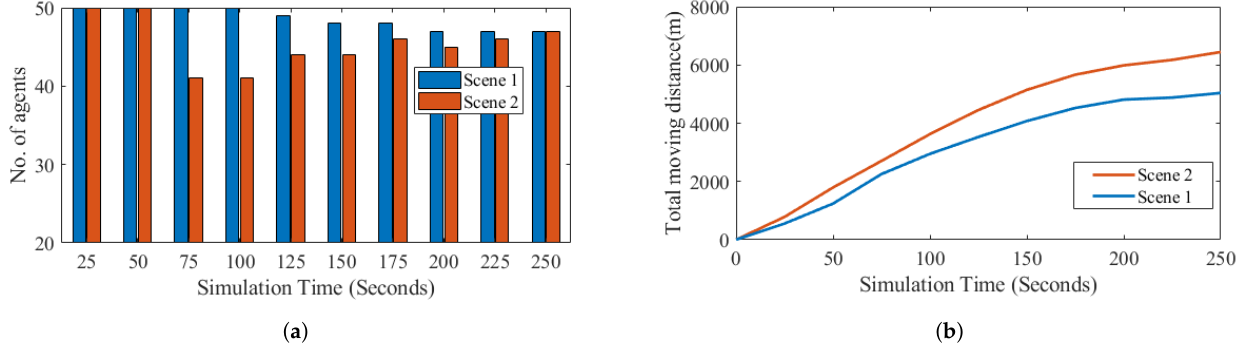
Figure 5. The total moving distance of all agents and number of agents satisfying connectivity constraint. ( a ) Number of agents satisfying degree constraint. ( b ) Moving distance of agent